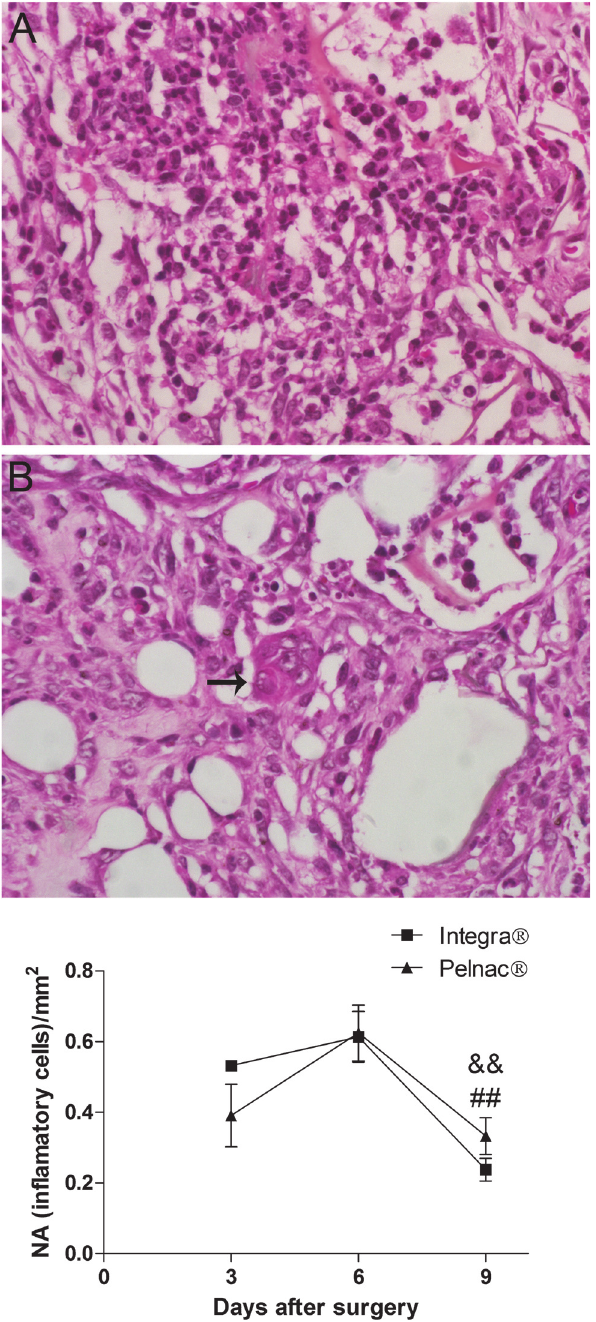
Fig 3. Histological aspects of wounds treated with dermal substitutes showing inflammatory cells. (A) Representative picture of HE-stained transversal section of a full-thickness skin wound. (B) Foreign-body giant cell (arrow). (C) Quantification of inflammatory cells during the 9 days after the surgical procedure. NA numerical density that represent the number of inflammatory cells per mm 2 . Data are expressed as the mean ± SEM of 5 animals. Not significant differences between the two templates were observed at any time point. && p = 0.001 Integra at day 6 vs . Integra at day 9 and ## p = 0.004 Pelnac at the day 6 vs . Pelnac at day 9 by two-tailed unpaired t-test. Original magnification 400X.